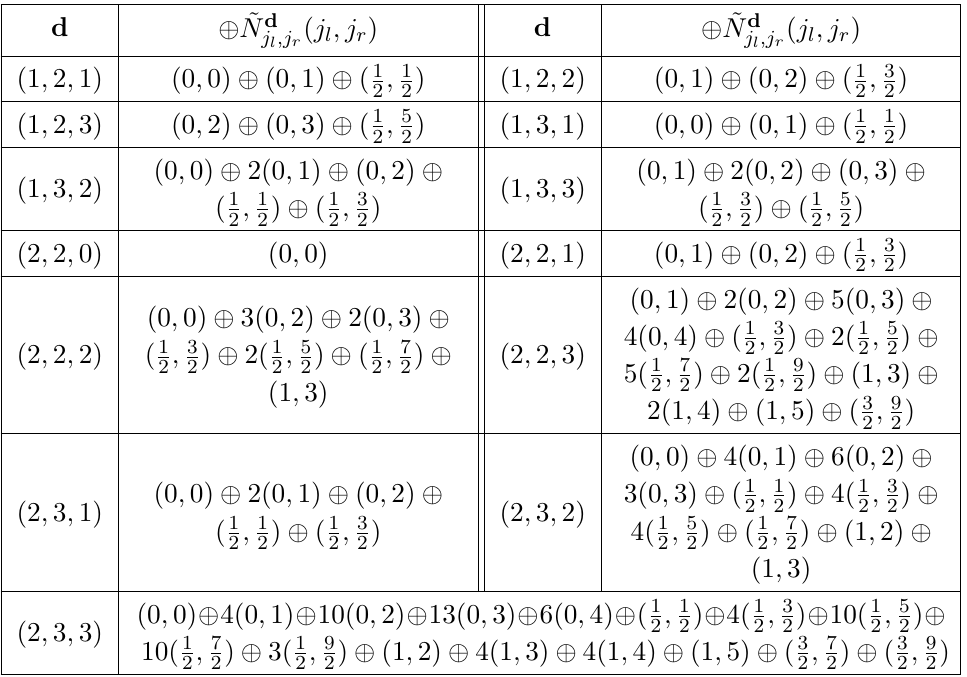
Table 22 . Spectrum of the Wilson loop operator in the rank-2 anti-symmetric representation in the SU(3) 9 theory for ( d 1 , d 2 , d 3 ) ≤ (2 , 3 , 3) . Here, d = ( d 1 , d 2 , d 3 ) labels the BPS states with fugacity Q Q d Q − 4 / 3 Q − 2 / 3 i 2 3 i